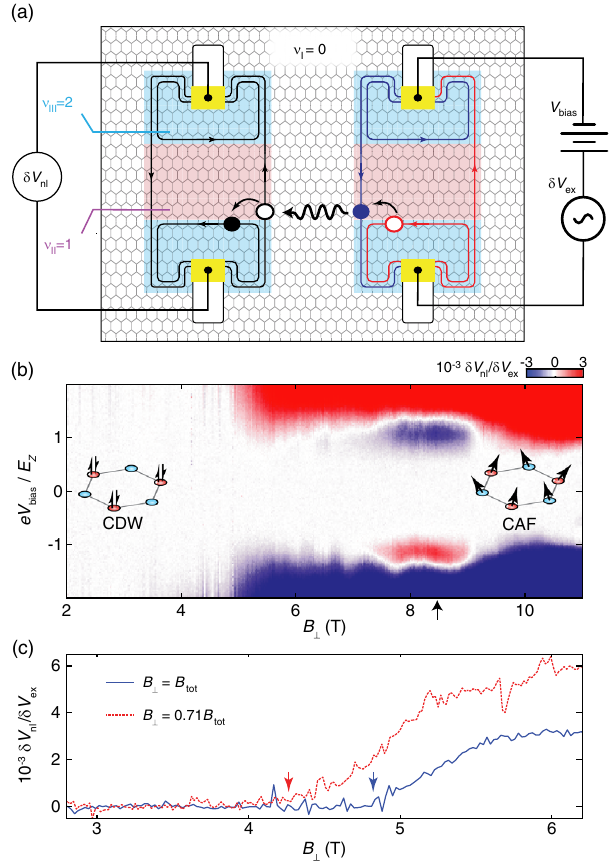
FIG. 9. Charge density wave to canted antiferromagnet tran- sition at ν ¼ 0 . (a) Schematic of the experiment. (b) Nonlocal 0 . The arrow indicates =E response versus eV and B ⊥ at ν Z bias I ¼ the value of B ⊥ where the incompressible ν ¼ 1 = 2 state appears. 1 . 74 . Dashed =E (c) Solid line: line cut of (b) at eV Z ¼ bias line: same measurement with a tilted magnetic field applied. B ⊥ ¼ 0 . 71 B . The arrows label the value of B ⊥ where the tot nonlocal voltage starts to